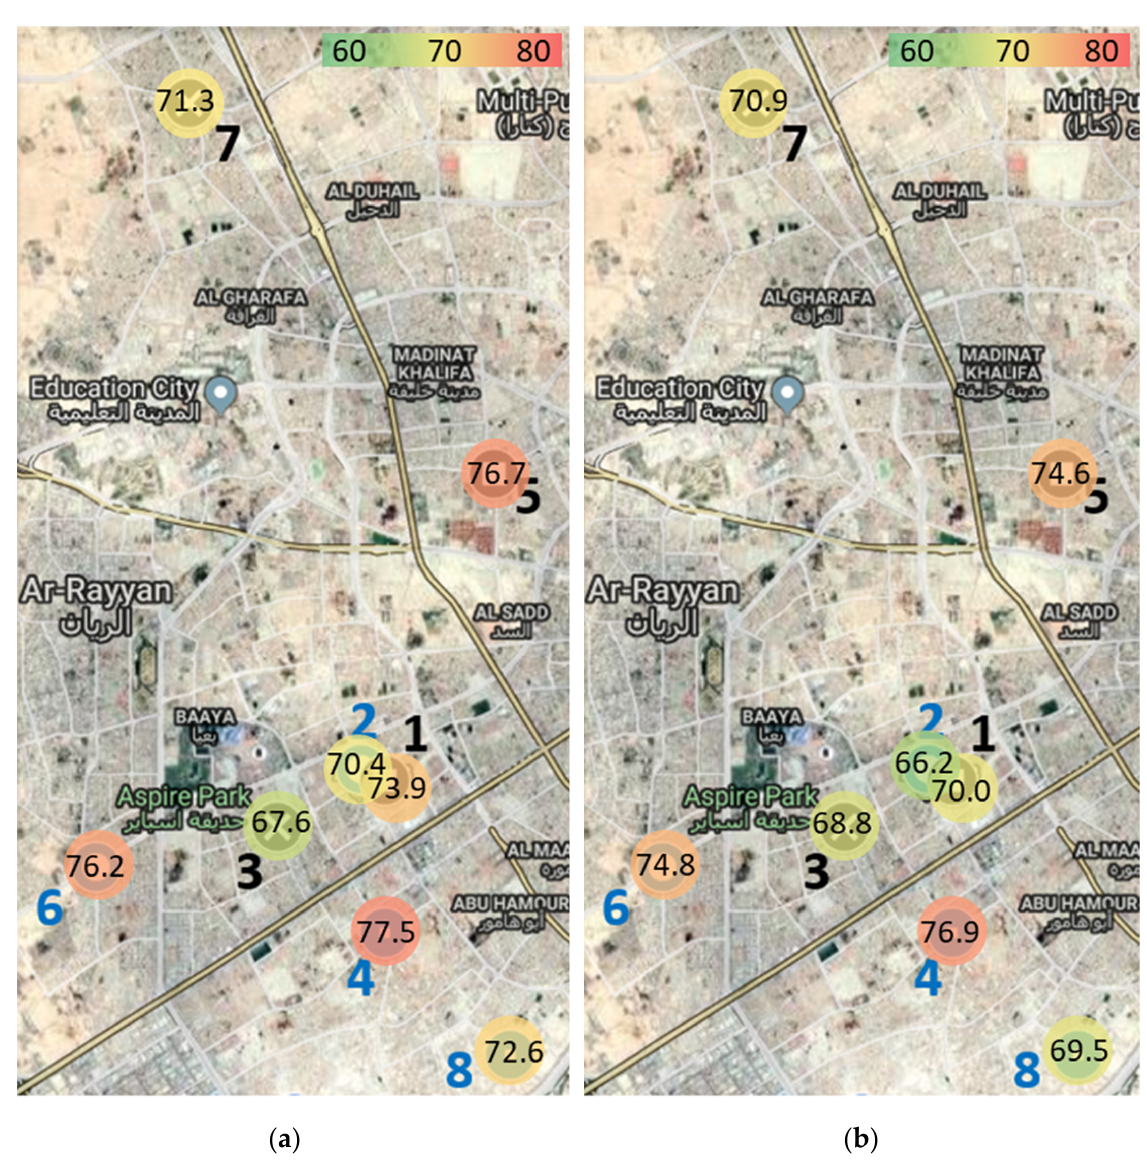
Figure 4. ( a ) Map of weekday daytime noise levels, L AFeq . Day (dB(A)); ( b ) map of weekend daytime noise levels, L AFeq . Day (dB(A)).